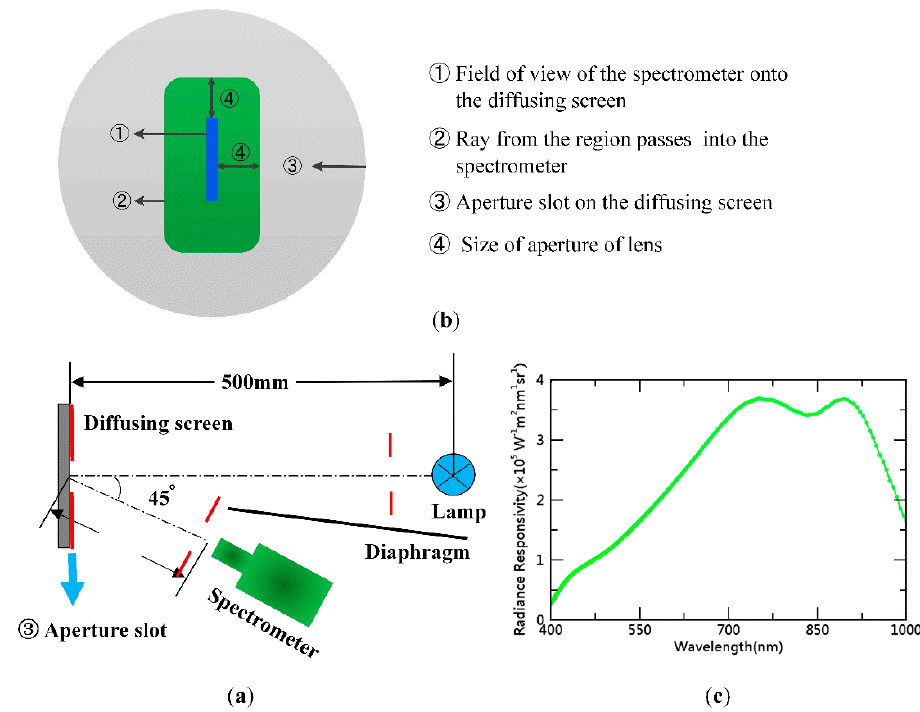
Figure 9. Radiometric calibration of the imaging spectrometer. ( a ) Schematic diagram of lamp–plate calibration system; ( b ) aperture slot setting; ( c ) spectral radiance responsivity. The aperture slot (3) is fixed onto the diffusing screen from (a) and (b), and the light from the effective area (green area in (b)) is able to be put into the spectrometer.